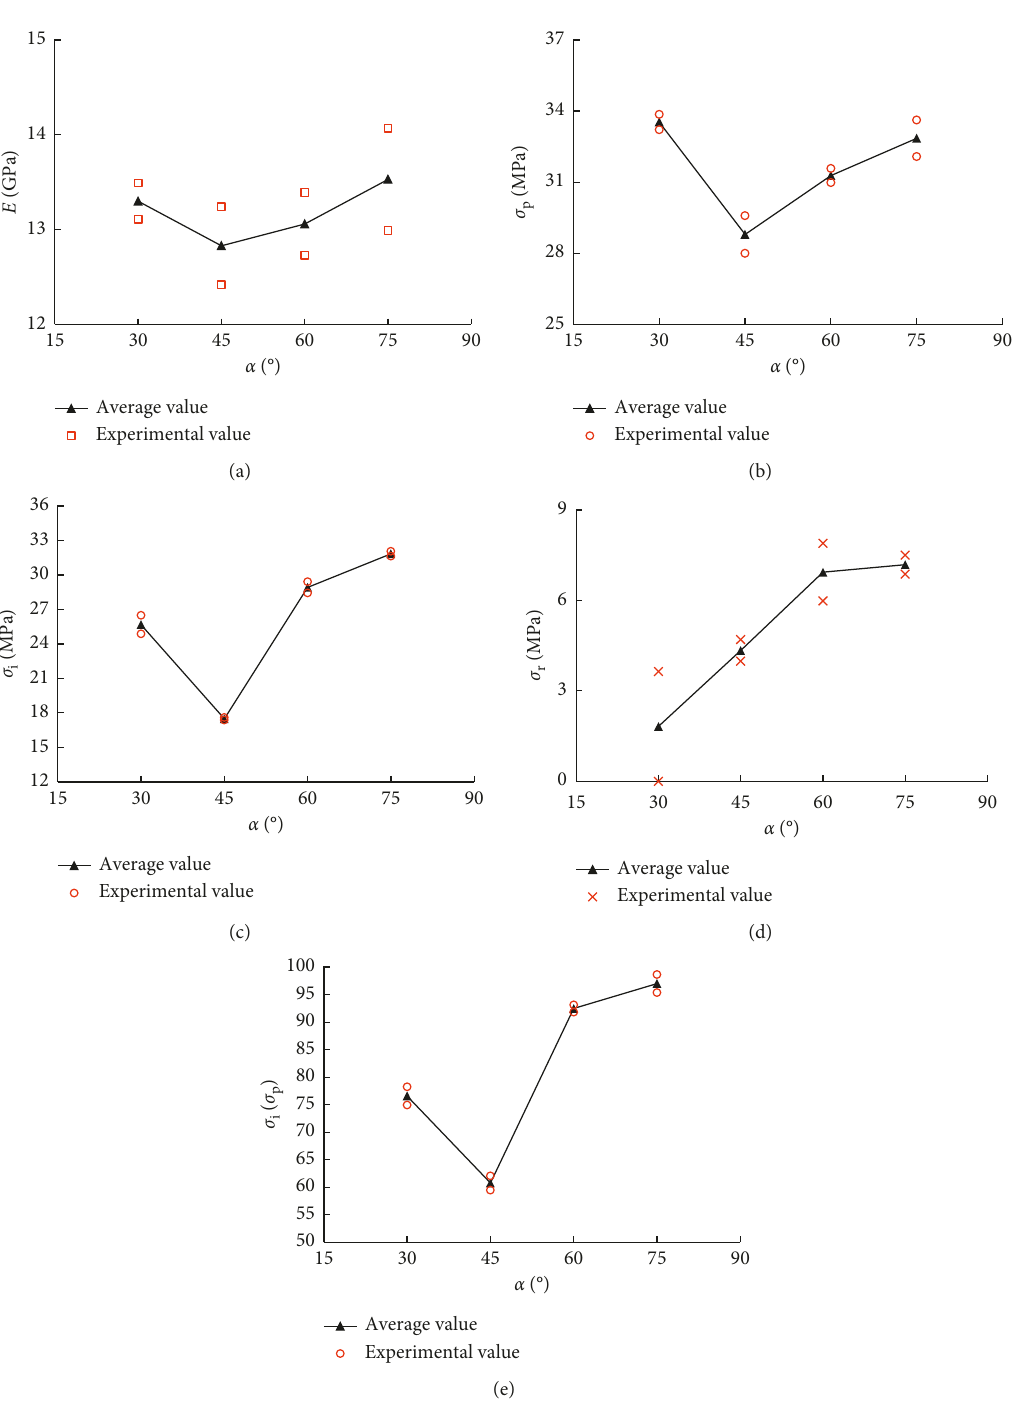
Figure 5: Influence of the flaw inclination angle on the strength and deformation parameters of specimens under uniaxial compression: (a) elastic modulus; (b) uniaxial compressive strength; (c) wing crack initiation strength; (d) residual strength; (e) ratio of σ i / σ p